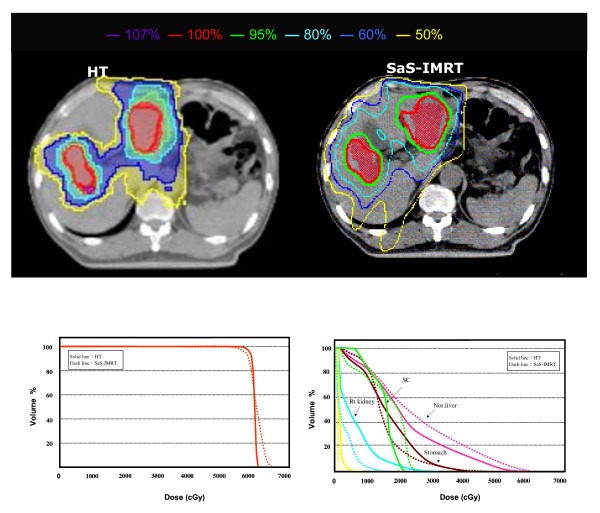
The comparison of isodose distributions of planned target volume (PTV) and organs at risk (OARs) in an axial plane for one patient in group 2 using the helical tomotherapy (HT) planning system versus step-and-shoot intensity-modulated radiotherapy (SaS-IMRT). DVH: Dose volume histograms; PTV = Planning target volume; OAR = Organ at risk